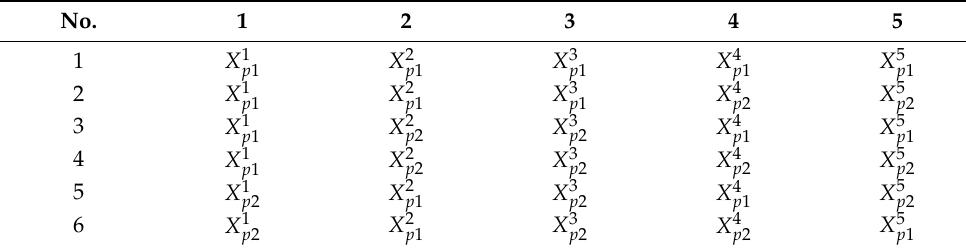
Table 9. Example of crossover performed using L 8 (2 7 ) for X p 1 and X p 2 with 5